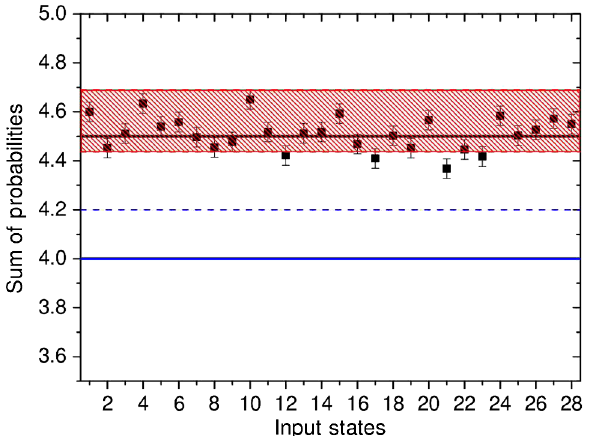
FIG. 3. Experimental results for (cid:2) for 28 quantum states. The solid (dashed) blue line refers to the (corrected) classical upper bound for (cid:2) . The red area represents the range ½ (cid:2) min ; (cid:2) max (cid:6) in which we theoretically expect to find all experimental values of (cid:2) . The first 18 states correspond to the ones in Fig. 1(a). States 19–28 are defined in Table I.